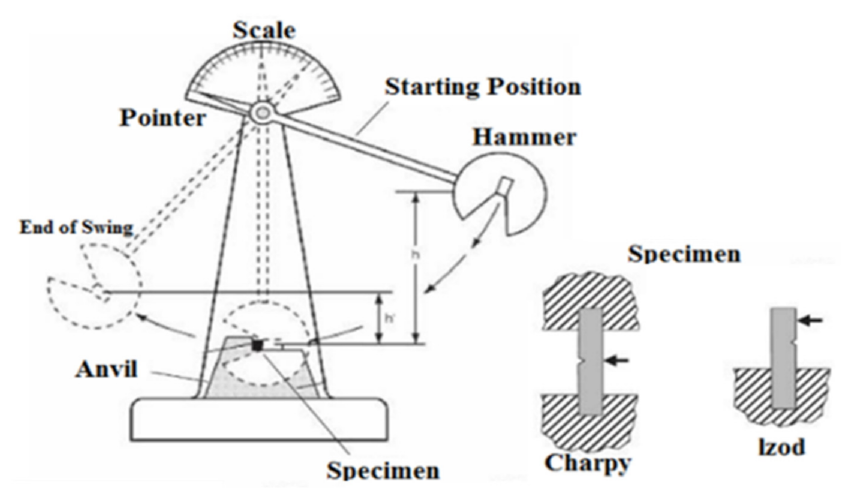
Figure 32. Charpy impact testing and Izod impact testing arrangement and sample design.